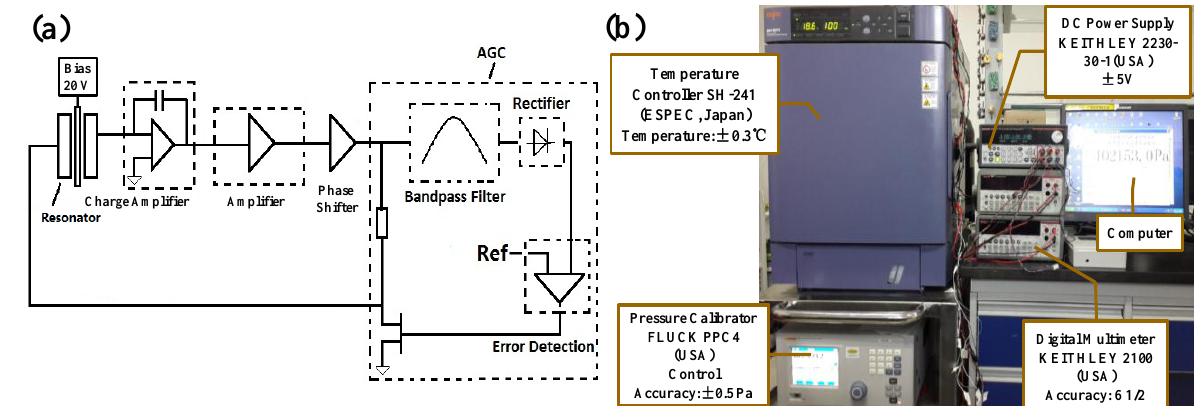
Figure 7. ( a ) The schematic of the closed-loop circuit used as a self-oscillator for frequency detection; ( b ) The setup used to characterize the sensor performance as functions of both pressure and temperature.